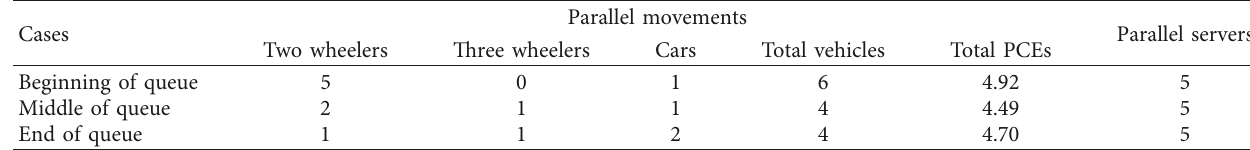
Table 6: Variation of parallel movements during queue dissipation.